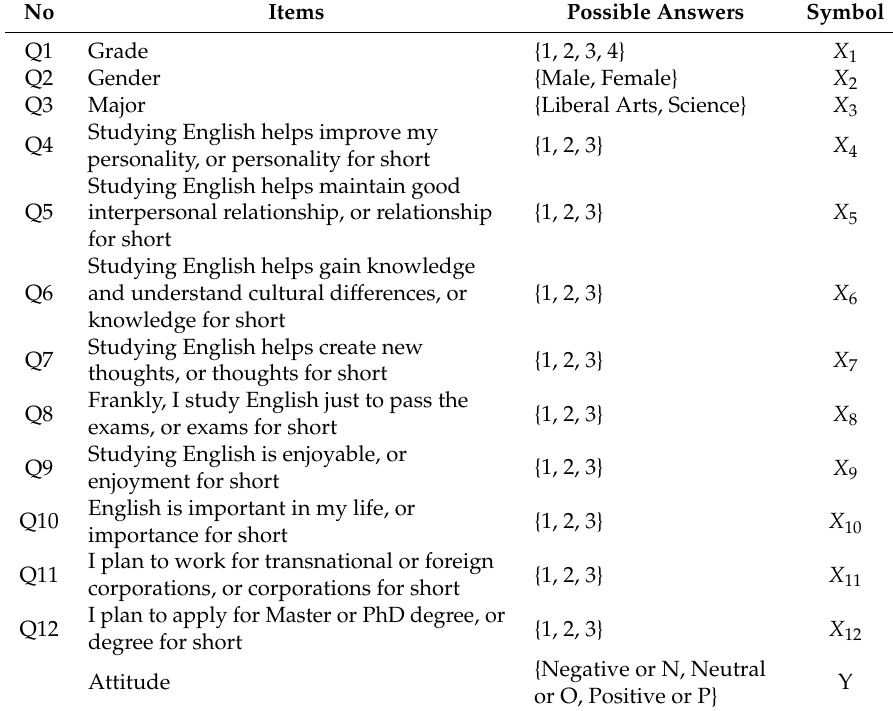
Table 1. Detail of the